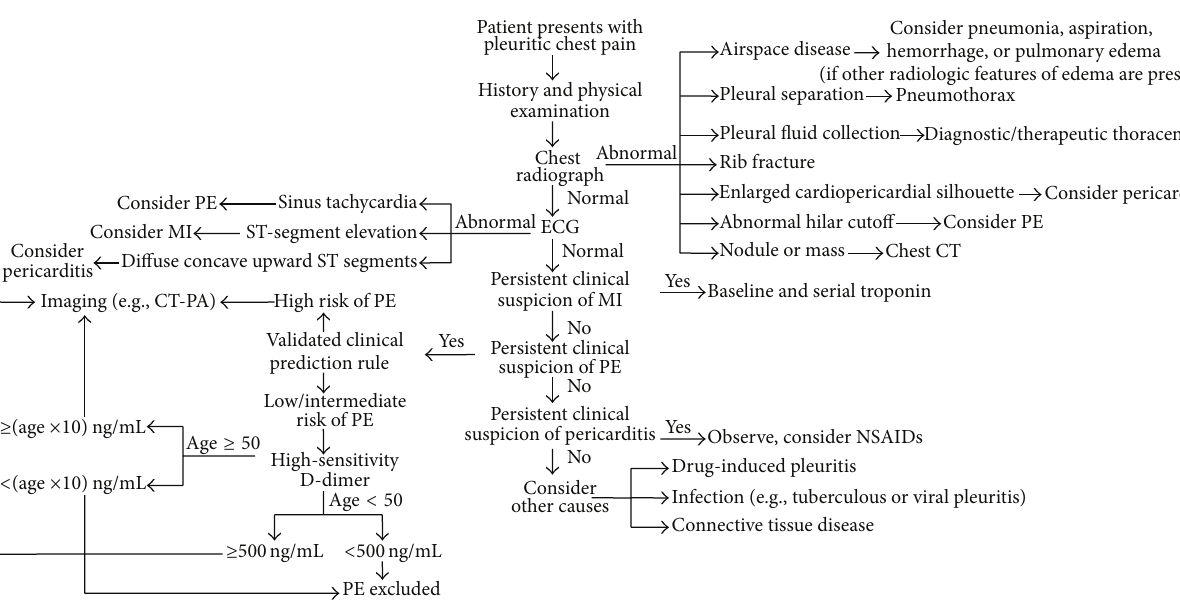
Figure 4: Diagnostic algorithm for pleuritic chest pain (modified from Kass et al. [18] and Cuker